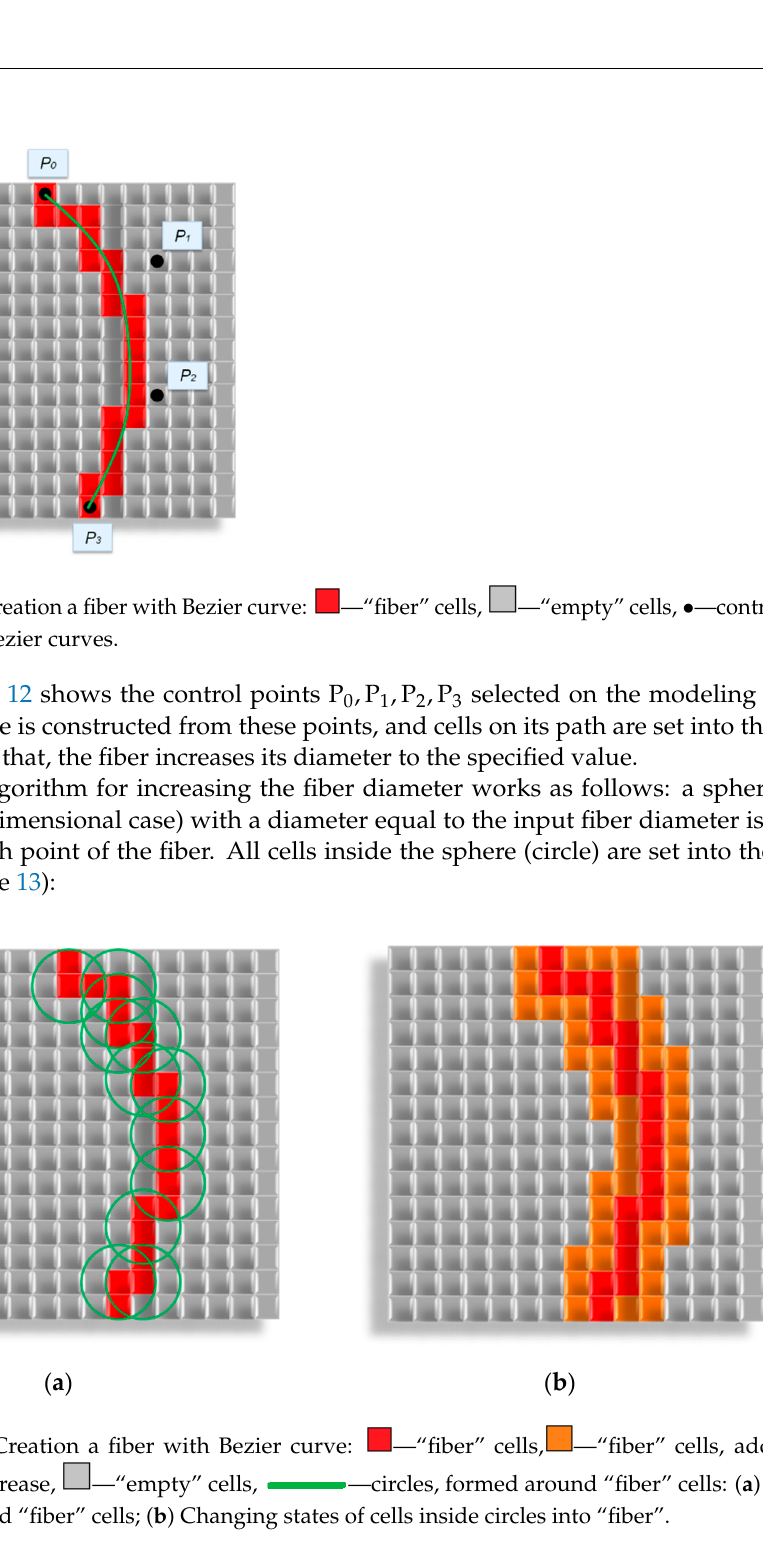
Figure 14. Sectional 3D digital structure of a chitosan-based aerogel. The proposed model was used to generate digital copies of the structures of experi- mental samples obtained in Section 2. The main goal in modeling of nanoporous structures such as aerogels is to obtain a digital copy of the material that corresponds to a specific sample. If the structures of the digital copy and the experimental sample correspond to each other, the digital copy can be used in the future to predict the properties of this sample. They correspond to each other if the deviation of the structure parameters of the digital copy from the structure parameters of the experimental sample does not exceed the specified accuracy. The key structure characteristics of aerogels are specific surface area and pore size distribution (PSD). These parameters influence the structure and aerogel properties such as thermal conductivity, sorption, and mechanical properties. Therefore, in this work, the PSD and the specific surface area were chosen as the criteria for the correspondence between the digital copy and the experimental sample their deviation from the experimental values should not exceed 15%.